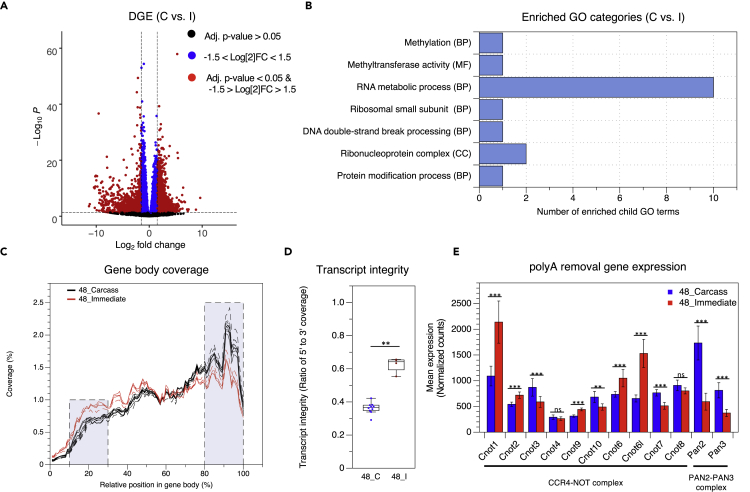
Gene Expression Changes and Transcript Integrity in Carcass versus Immediate RR-1 NASA Liver Samples(A) Volcano plot showing 2,934 differentially expressed genes in all carcass (both spaceflight and ground control) versus all immediate (both spaceflight and ground control) samples (adj. p value < 0.05 and 1.5 < Log2 fold change < −1.5).(B) Common parent terms of enriched gene ontology (GO) terms identified by Gene Set Enrichment Analysis of all carcass (C) versus all immediate (I) samples (phenotype normalized, FDR <0.3, NOM p < 0.01).(C) Gene body coverage in Carcass (black) and Immediate (red) spaceflight and ground control samples.(D) The percent coverage of the 5′- and 3′-shaded regions in panel C were used to calculate the 5′ to 3′ transcript integrity ratio for each sample. All Carcass (blue) and Immediate (red) samples are grouped together (∗∗ = p < 0.01, Mann–Whitney U test).(E) Average expression of polyA removal genes in Carcass (blue) and Immediate (red) groups from RNAseq data. Cnot1, Cnot2, Cnot3, Cnot4, Cnot9, Cnot10, Cnot6, Cnot6l, Cnot7, and Cnot8 are part of the CCR4-NOT complex. Pan2 and Pan3 are part of the PAN2-PAN3 complex. Error bars indicate standard deviation (∗ = adj. p < 0.05, ∗∗ = adj. p < 0.01, ∗∗∗ = adj. p < 0.001, ns = not significant, Wald test). Data are from GLDS-48.